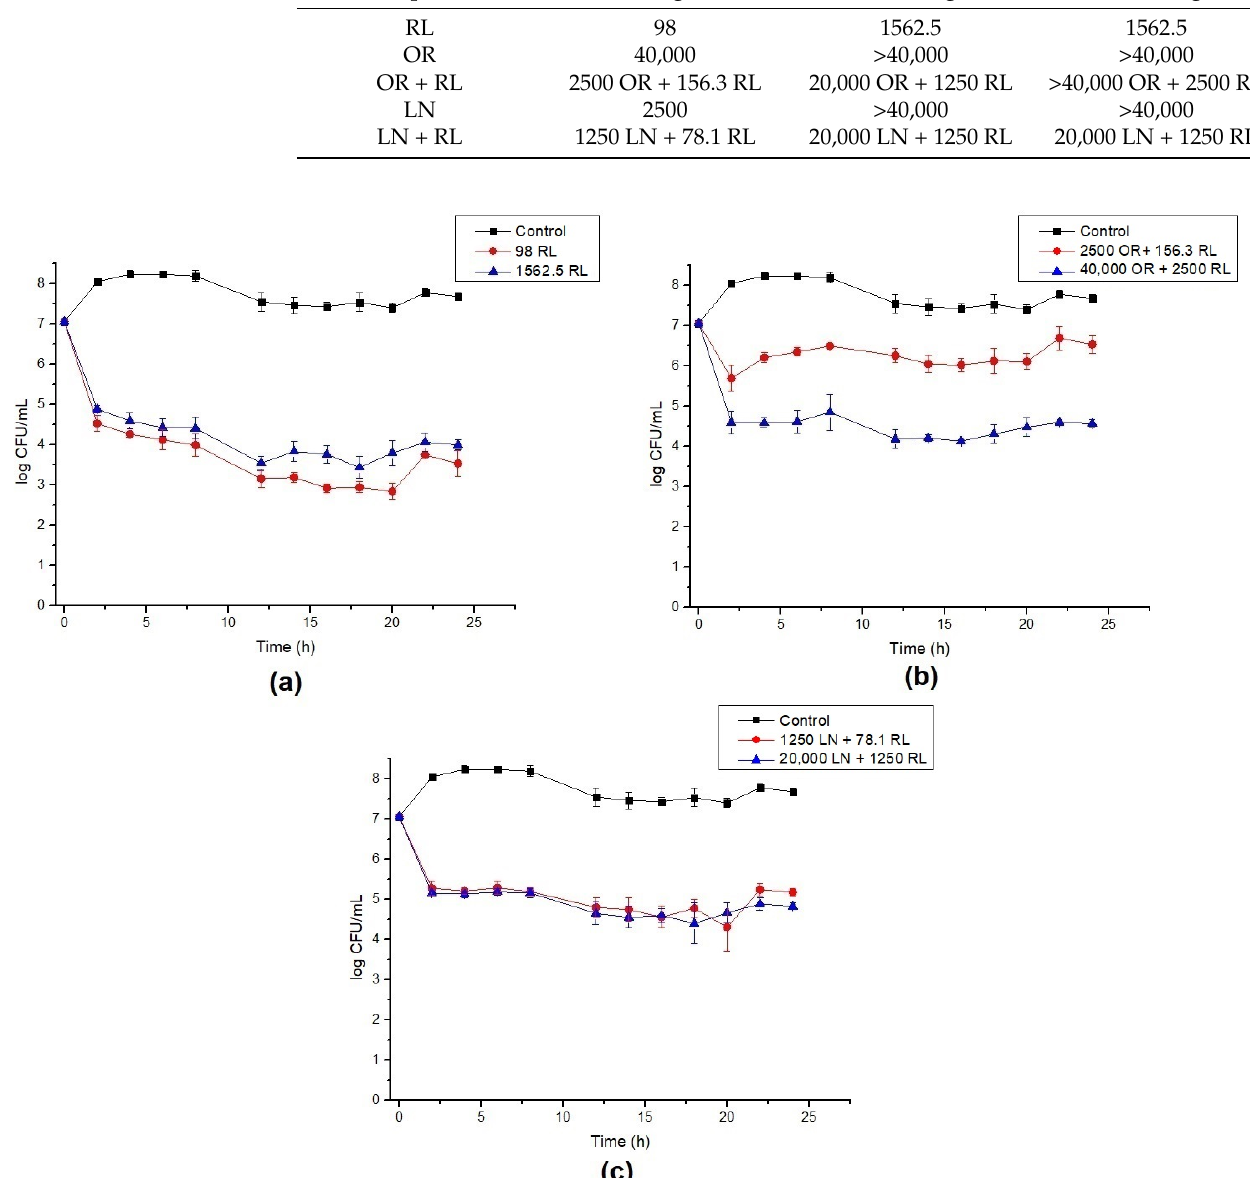
Figure 1. Time–kill curves for B. cereus with ( a ) rhamnolipid (RL), ( b ) celery oleoresin (OR) + RL, and ( c ) limonene (LN) + RL. Lines show the log CFU/mL for the control (black), minimum inhibitory concentration (MIC) (red), and 16× MIC (blue). Error bars show the standard deviation of at least three independent replicates.